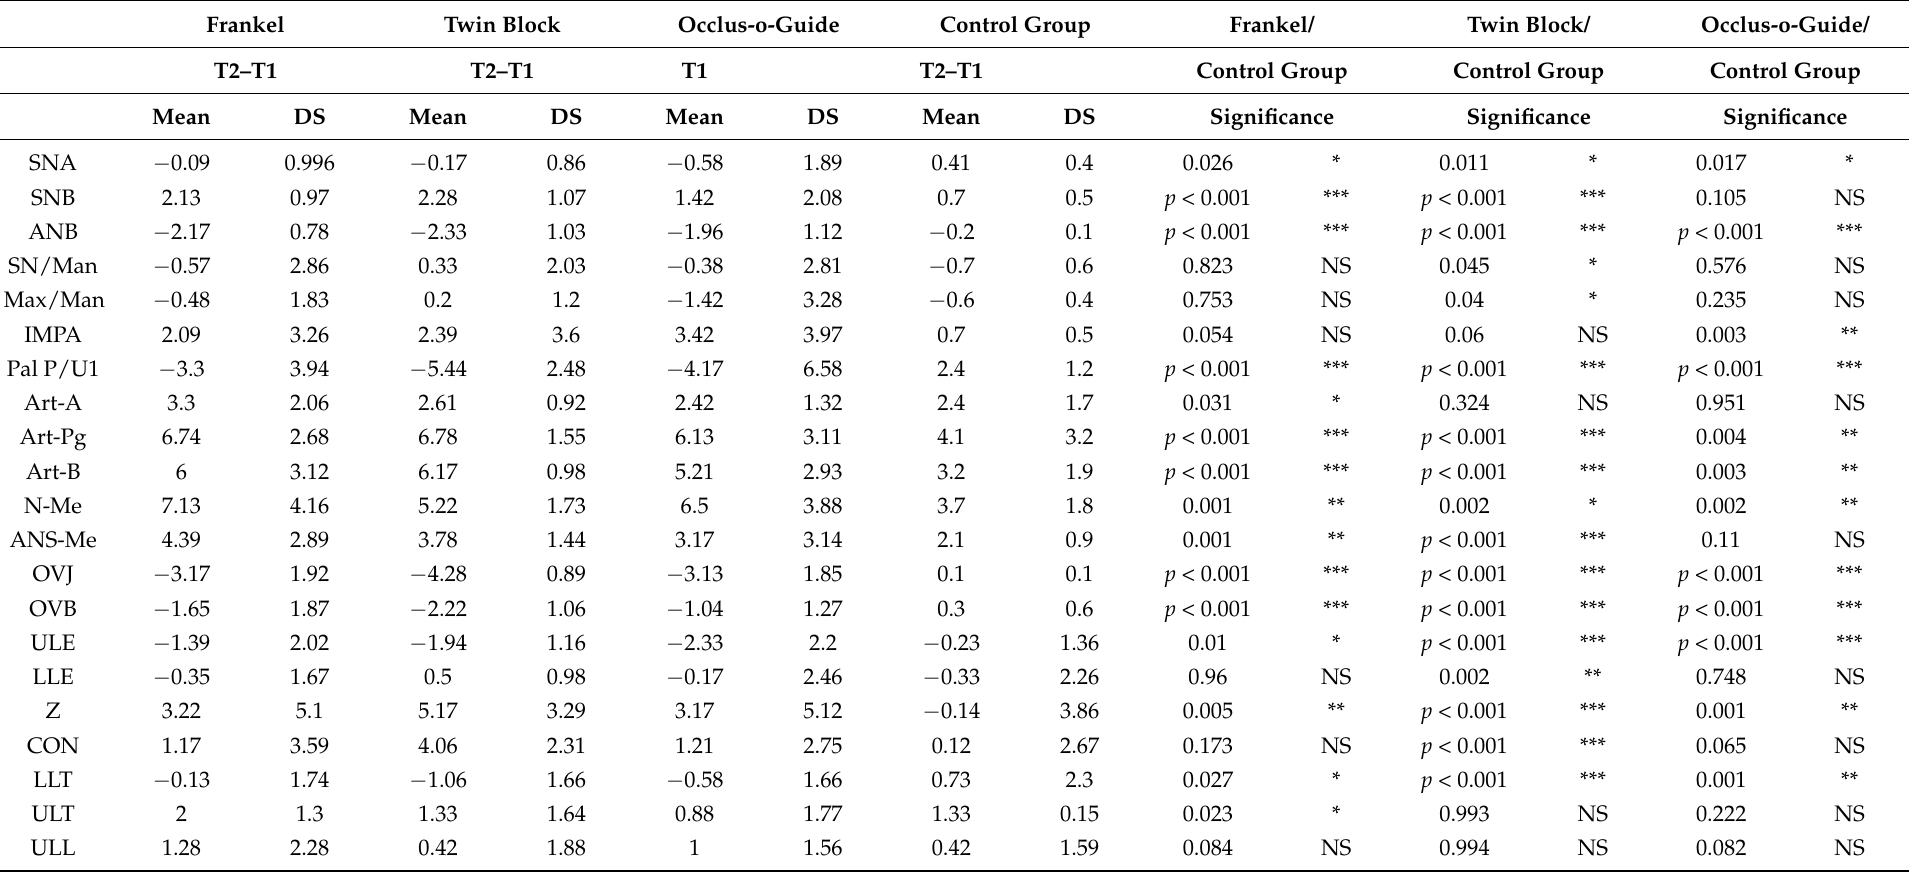
Table 7. Comparison of mean differences between treated and control